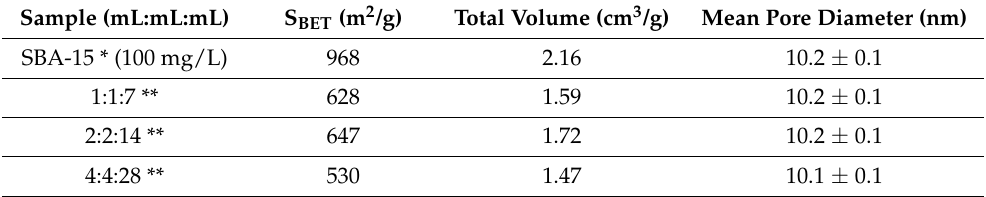
Table 2. Solutions tested in the study. * SBA-15 (Santa Barbara Amorphous 15, OMS) ordered mesoporous silica (OMS). ** (Ci:Me:Mi). The surface area, total pore’s volume, and mean pore diameter were determined using ASAP 2020-Micromeritics ® (ATS Scientific Inc., Burlington, ON, Canada) porosimeter in nitrogen